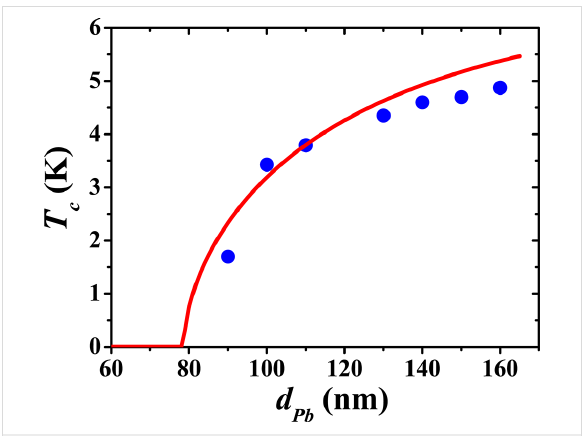
Figure 1: SC critical temperature T c as a function of the thickness of the Pb layer d Pb at a fixed thickness of the Ni layer d Ni = 5 nm for the trilayer Ni(5 nm)/Cu(1.5 nm)/Pb. Solid line is the theoretical fit accord- ing to [12] with the coherence length of the Pb layer of ξ S = 41